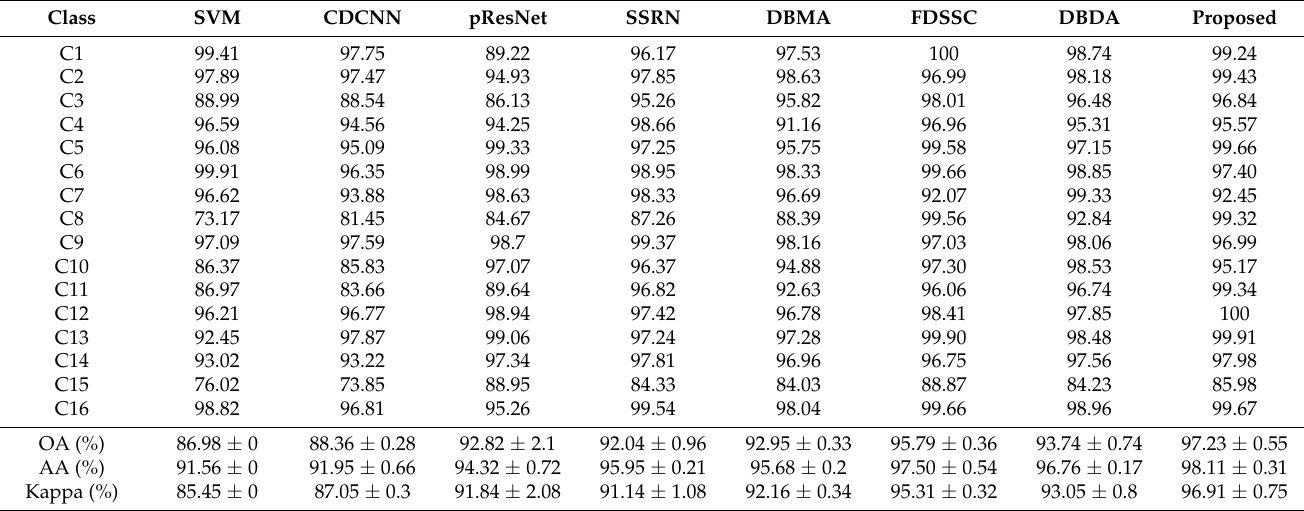
Table 8. KPI (OA, AA, Kappa) on Salinas Valley (SV) data set with 0.5% training samples.